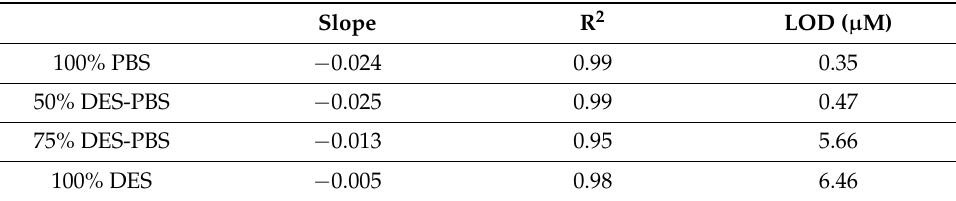
Table 1. The slopes of the calibration lines, the coefficients of determination, and the limits of detection for each calibration line. Slope R 2 LOD ( µ M) 100% PBS − 0.024 0.99 0.35 50% DES-PBS − 0.025